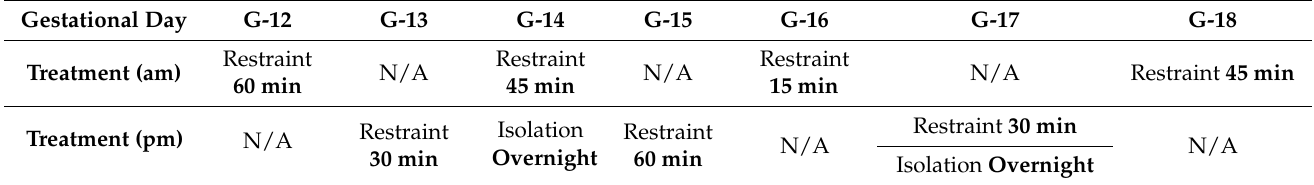
Table 1. Description of stress procedures implemented through GD12-18 using restraint and social isolation. N/A describes periods when the rodents were not